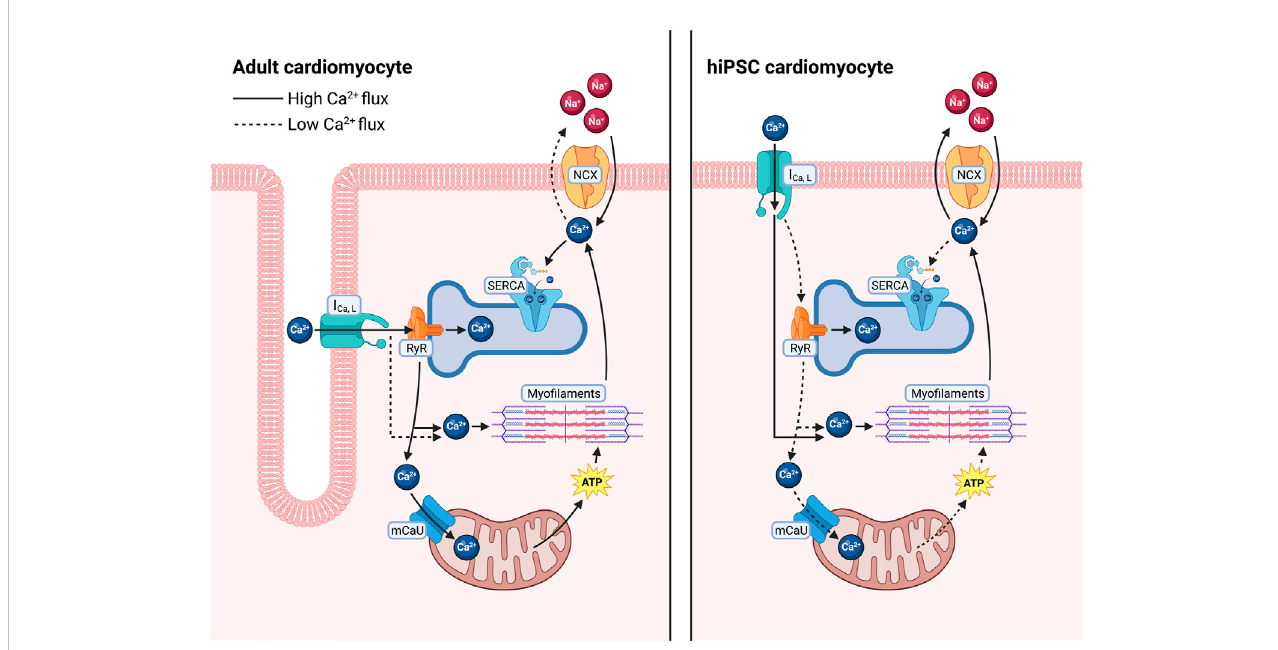
FIGURE 1 Differences in calcium regulation between adult human cardiomyocytes and in hiPSC-derived cardiomyocytes. In adult human cardiomyocytes (left), T-tubules result in close proximity between L-type Ca 2+ channels and RyR2 allowing for alarger release of Ca 2+ from theSR, quickly diffusing into the cytosol and going to the myo fi laments to facilitate contraction as well as into closely tethered mitochondria to stimulate ATP production. Ca 2+ is then primarily sequesteredback intothe SR via SERCA.In hiPSC-CMs (right), increased distancebetweenL-typecalcium channels and RyR2results in lessCa 2+ release from the SR, requiring the cells to rely more heavily on L-type Ca 2+ in fl ux to facilitate contraction. After relaxation a larger fraction of the cytosolic Ca 2+ is removed via the Na + /Ca 2+